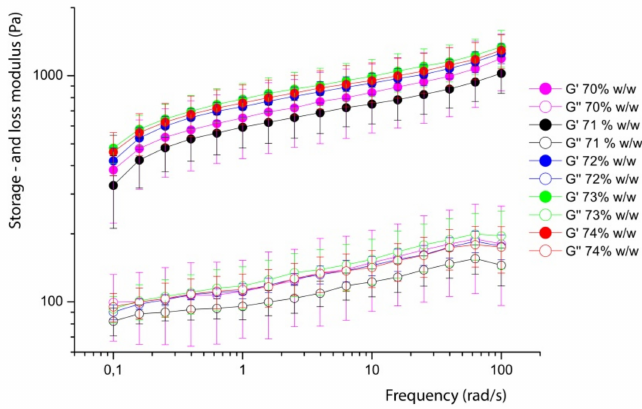
Figure 12. The storage ( G ’) and loss ( G’ ’) modulus in frequency sweep of fresh milk emulsions from 70% w / w to 74% w / w oil at deformations γ =